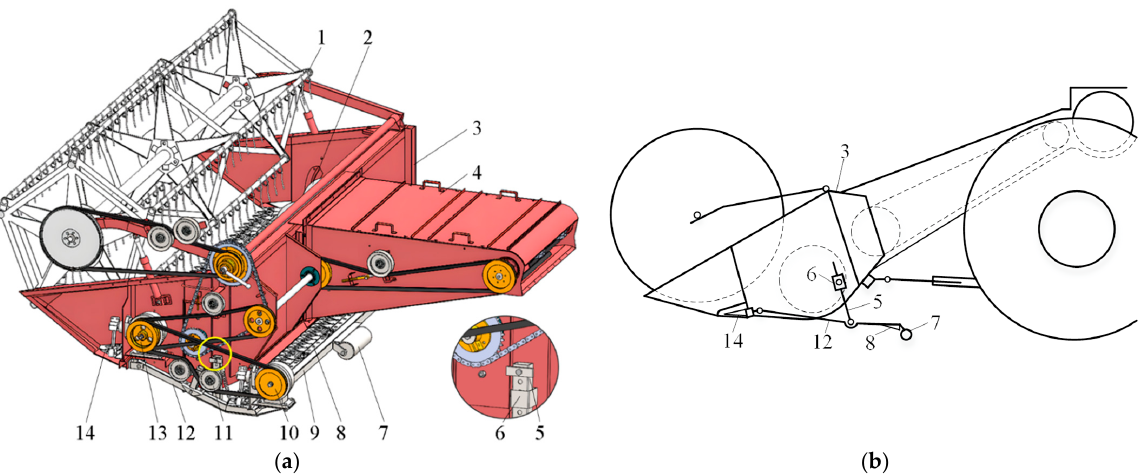
Figure 1. Structure of the DCH. ( a ) Three-dimensional structural diagram of the DCH; ( b ) Structural diagram of the profiling mechanism. 1. Reel; 2. Screw conveyor; 3. Frame; 4. Inclined conveyor; 5. Height-limiting connecting rod; 6. Swing block; 7. Ground wheel; 8. Lower cutterbar; 9. Fixed beam; 10. Wobble box of the lower cutterbars; 11. Belt expansion device; 12. Support arm; 13. Wobble box of the upper cutterbars; 14. Upper cutterbar.